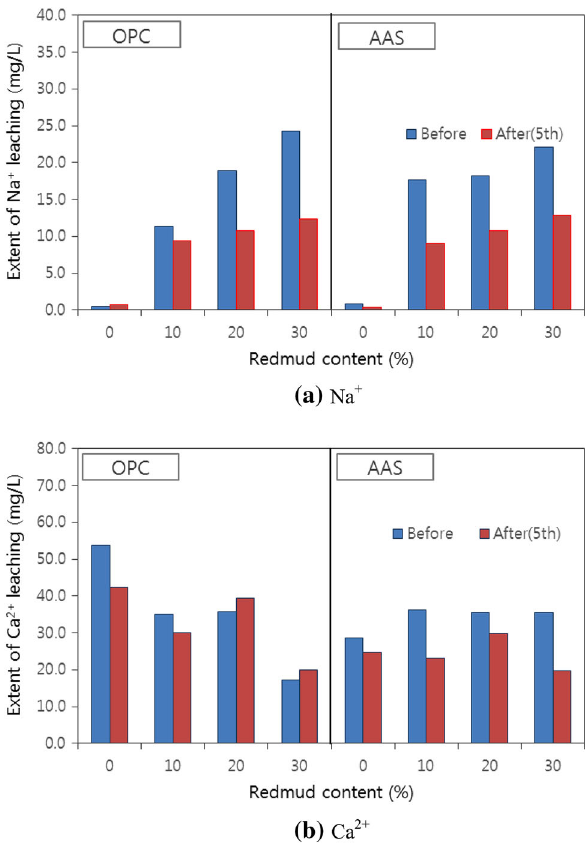
Fig. 11 Results of alkali leaching test with red mud replace- ment ratio.